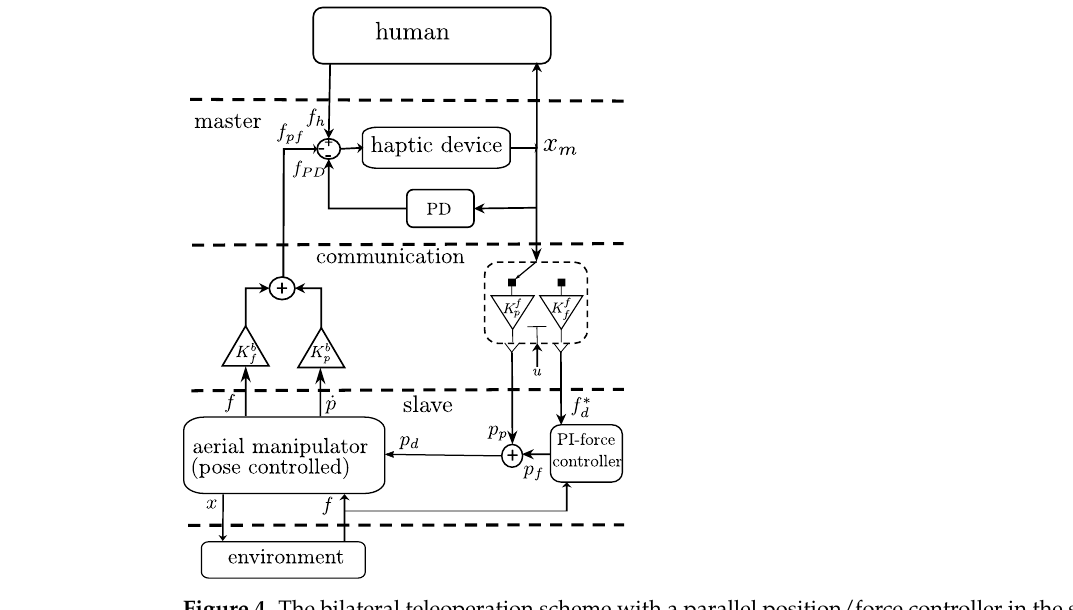
Figure 4. The bilateral teleoperation scheme with a parallel position/force controller in the slave side to control an aerial manipulator.